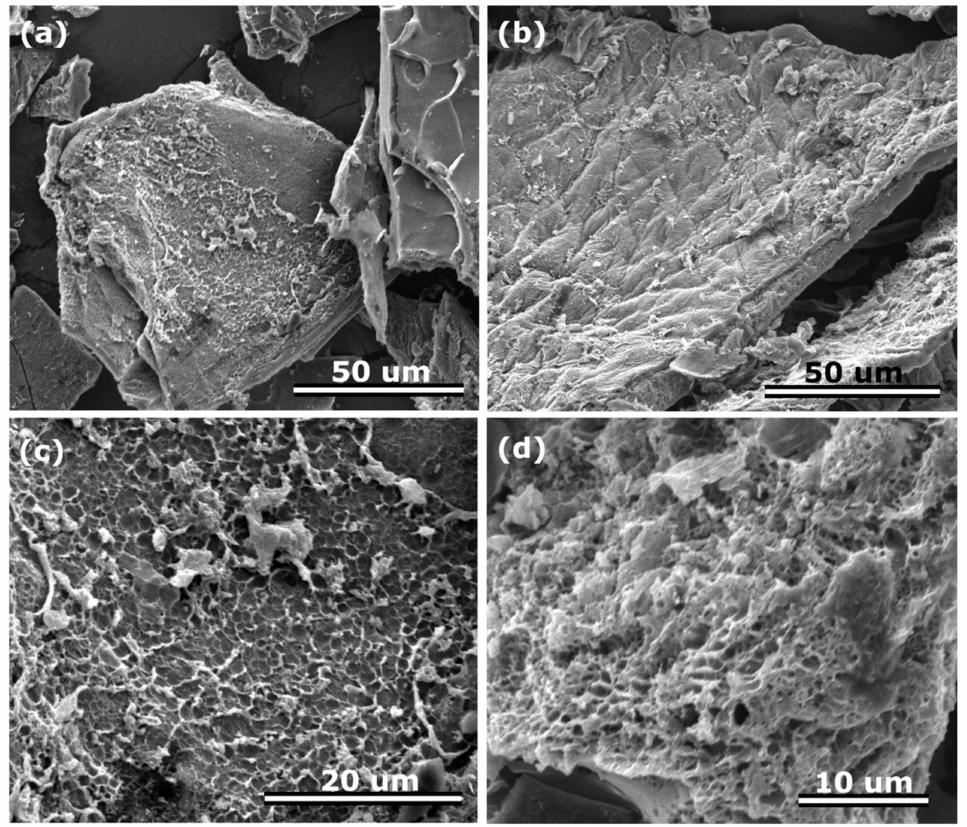
Figure 1. SEM images ( a – d ) of CH_K with different